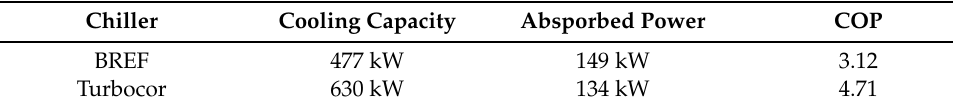
Figure 1. Configuration diagram of cooling units. Table 1. Technical parameters of the